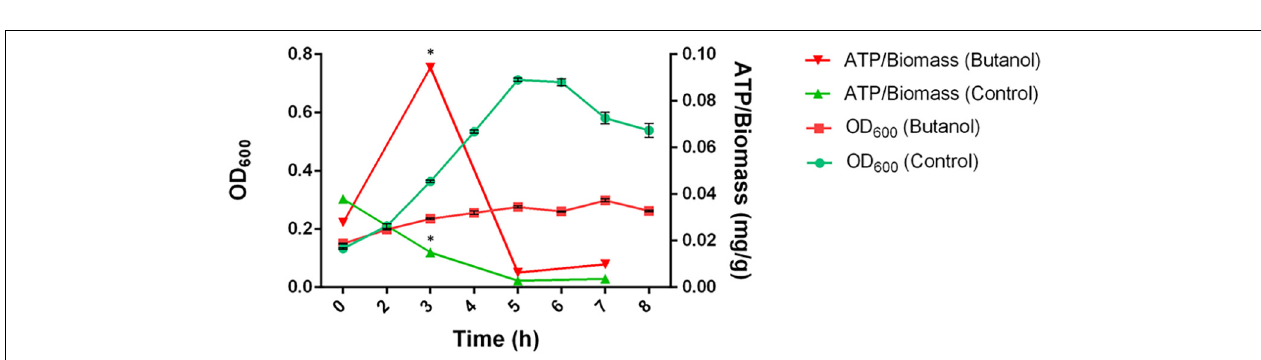
FIGURE 8 | The acetyl-CoA–butyrate pathway is down-regulated in butanol-challenged C. cellulovorans . Gene loci encoding the pathway enzymes are represented in colors indicating their level of relative expression in butanol-supplemented cultures (green, down-regulated; black, identified but not differentially expressed, blue, not identified). Abbreviations: Bcd/EftAB, butyryl-CoA dehydrogenase/electron transfer protein; Buk, butyrate kinase; Crt, crotonase; Fd, ferredoxin; H 2 ase, hydrogenase; Hbd, 3-hydroxybutyryl-CoA dehydrogenase; Pbt, phosphate butyryltransferase; Thl, thiolase.